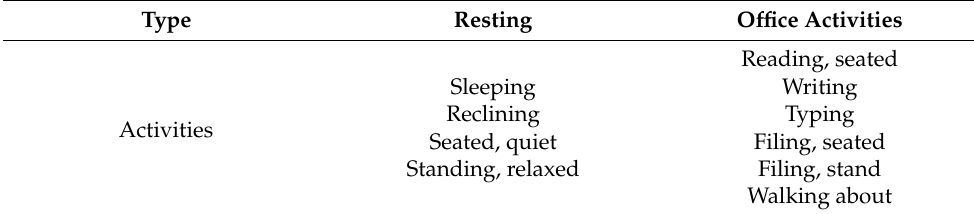
Table 1. 10 representative indoor activities.